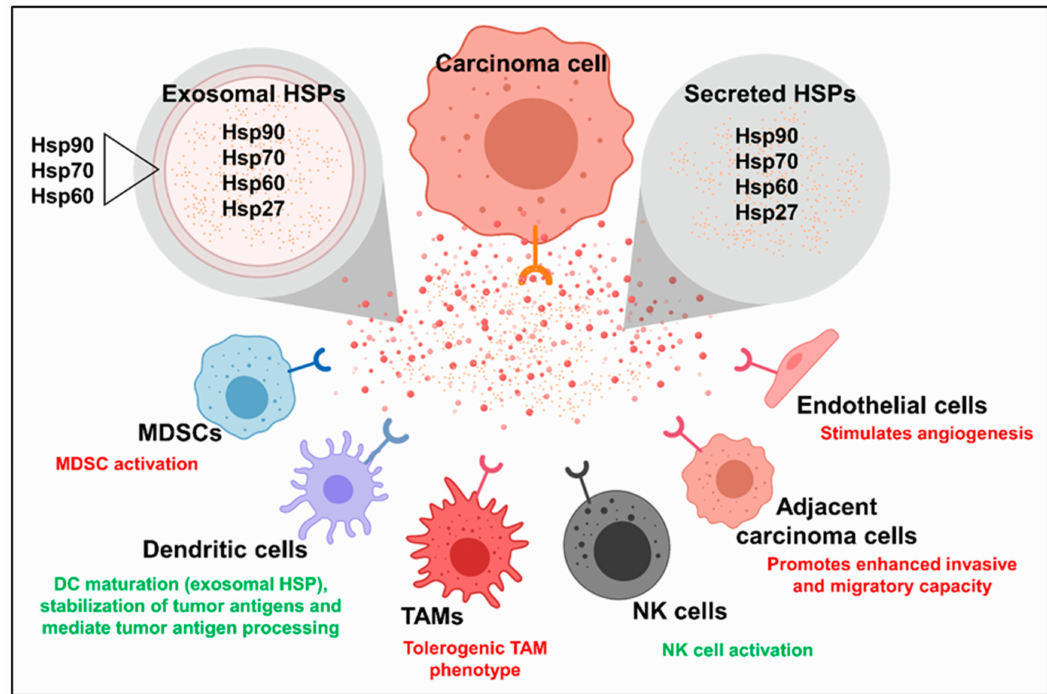
Figure 6. Tumor cells can modulate the tumor microenvironment by secreting HSPs. Carcinoma cells derived from several tissues have been identified to secrete HSPs into the extracellular space in soluble form or within exosomes. HSP species, including those listed above, are often abundant within the lumen of tumor cell-derived exosomes or within the exosomal membrane. HSPs secreted from carcinoma cells in soluble form or within exosomes can modulate the biology and functions of other cells in the tumor microenvironment. Specifically, secreted HSPs have been shown to modulate the activities of myeloid-derived suppressor cells (MDSCs), dendritic cells, TAMs, natural killer (NK) cells, other / neighboring carcinoma cells, and endothelial cells. Extracellular HSPs can promote tumorigenic processes (listed in red text), including immunosuppressive MDSC activity, carcinoma cell invasion and migration, and angiogenesis. Alternatively, extracellular HSPs can also promote tumor immunity (listed in green text) by stabilizing tumor antigens, stimulating TAMs to secrete inflammatory cytokines, and by mediating antigen processing by antigen presenting cells